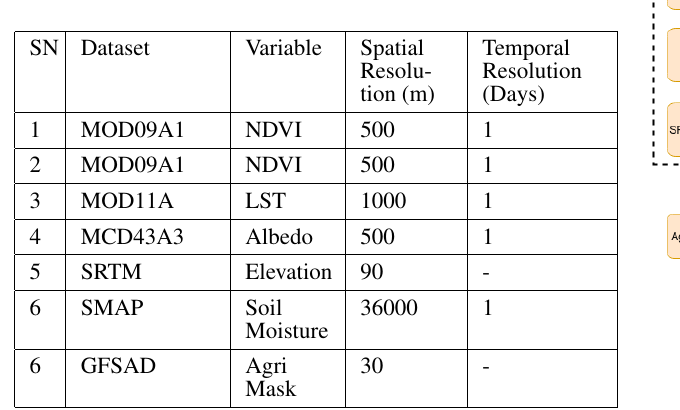
Table 1. Description of datasets used in the study